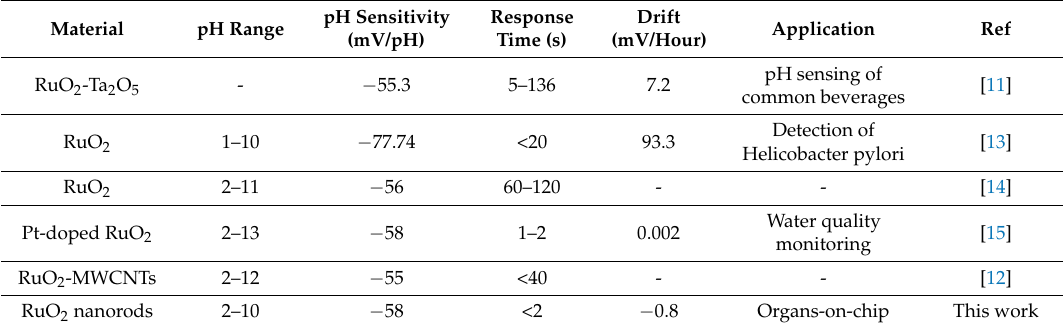
Table 1. Summary of recent works on RuO 2 pH sensors, their results, and